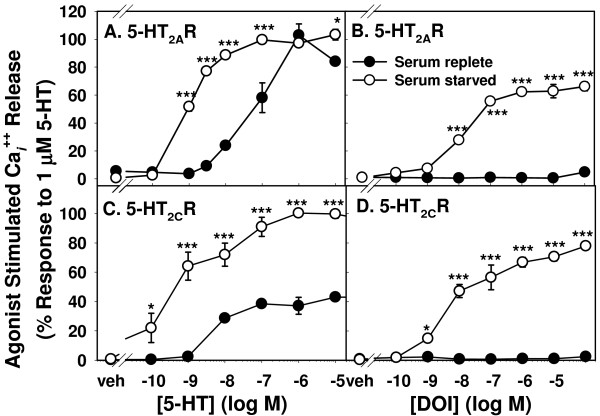
Concentration and serum preincubation dependence of Cai++ release by 5-HT and DOI in CHO cells expressing 5-HT2AR (A, B) or 5-HT2CR (C, D). Cells plated at 16,000 cells/well in 96-well plates for 24 hrs were either preincubated overnight in serum-free (open circles) or in serum-replete (closed circles) medium and loaded with Calcium 4. Peak height following stimulation was recorded for each well and normalized to the maximal response to 5-HT. n = 5-6; * p < 0.05, *** p < 0.001 vs. respective serum preincubation.